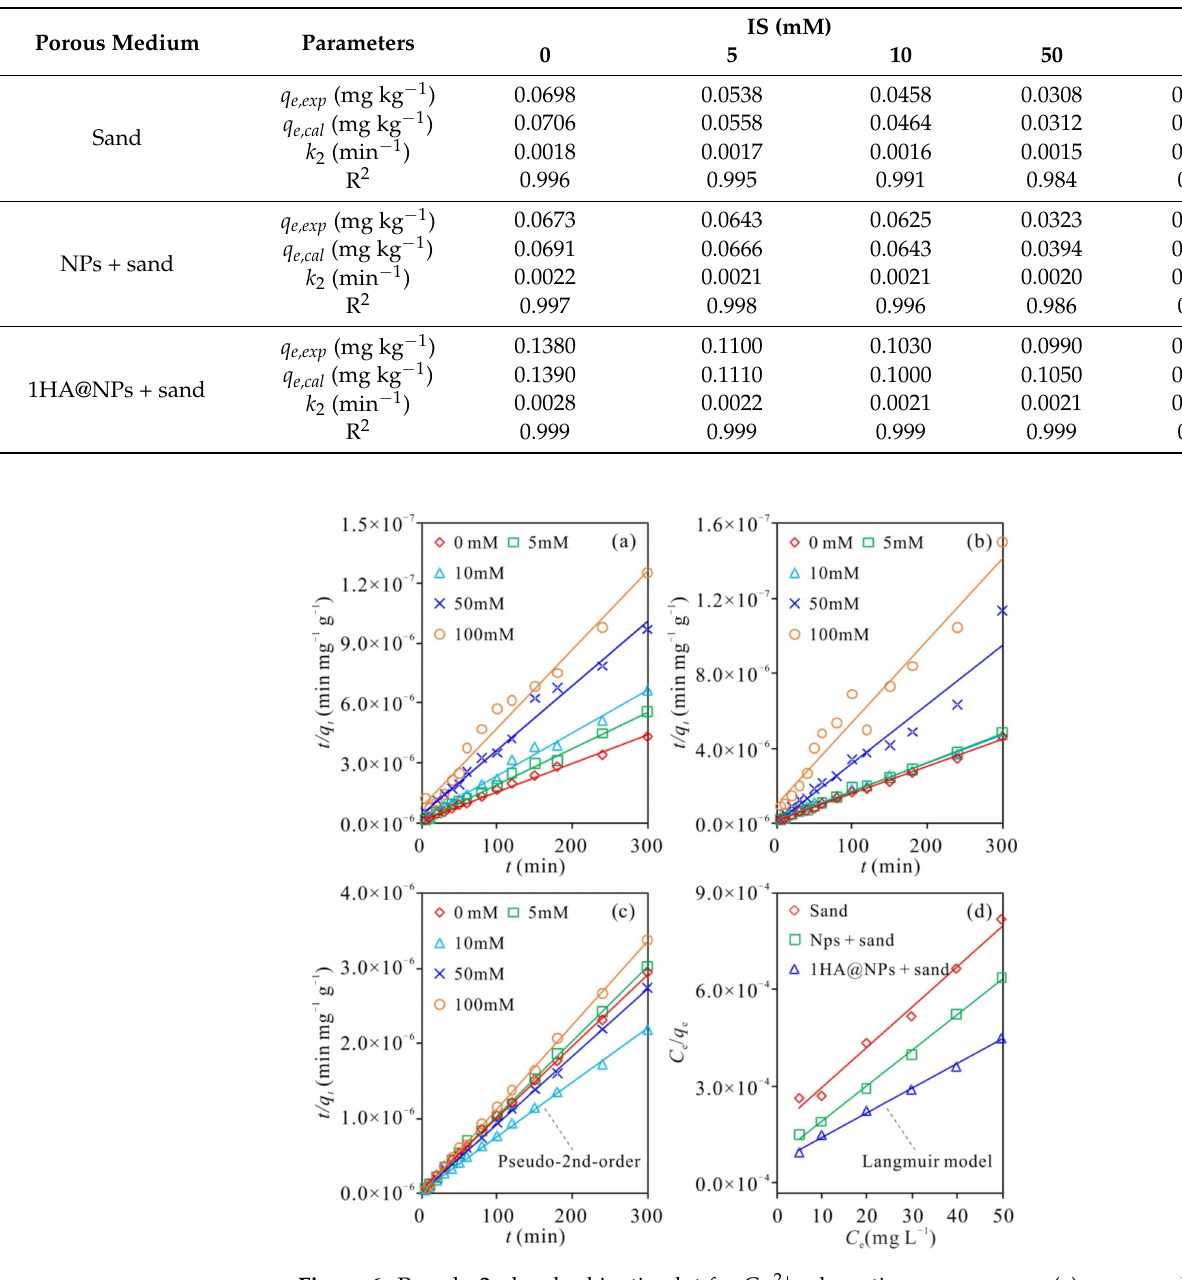
Figure 6. Pseudo-2nd order kinetic plot for Cu 2+ adsorption processes on ( a ) pure sand, ( b ) NPs + sand, and ( c ) 1HA @NPs + sand at different IS values; ( d ) fitting results of Langmuir models for Cu 2+